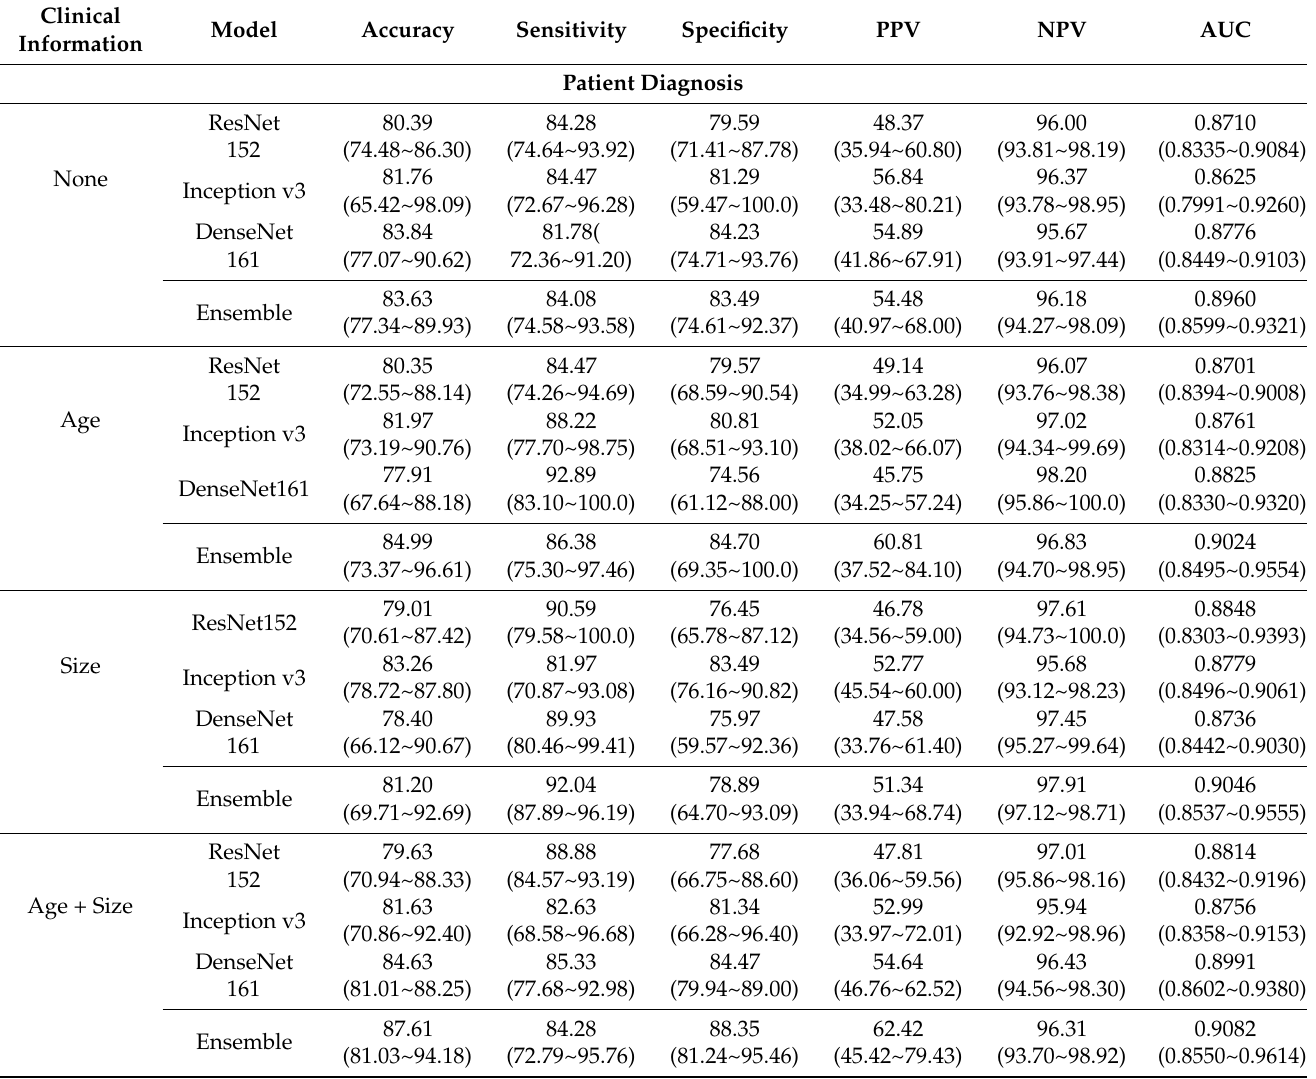
Table 2. Diagnostic performances of the individual models and ensemble model according to the addition of clinical information. All results were calculated based on the thresholds at which the Youden index was highest. Data in parentheses are 95% confidence intervals. PPV: positive predictive value, NPV, negative predictive